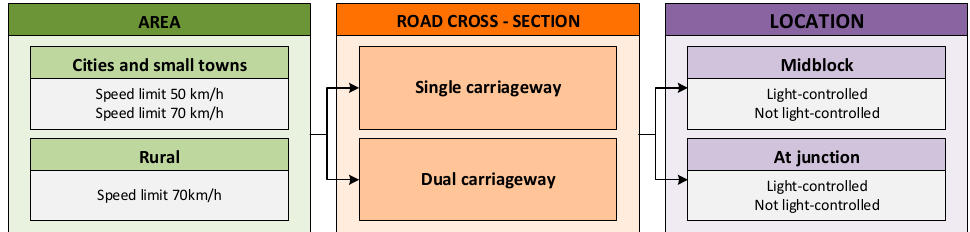
Figure 3. Diagram of test point selection.